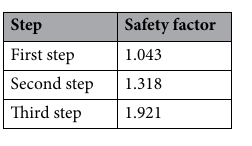
Table 2. Safety factors of the steps at all